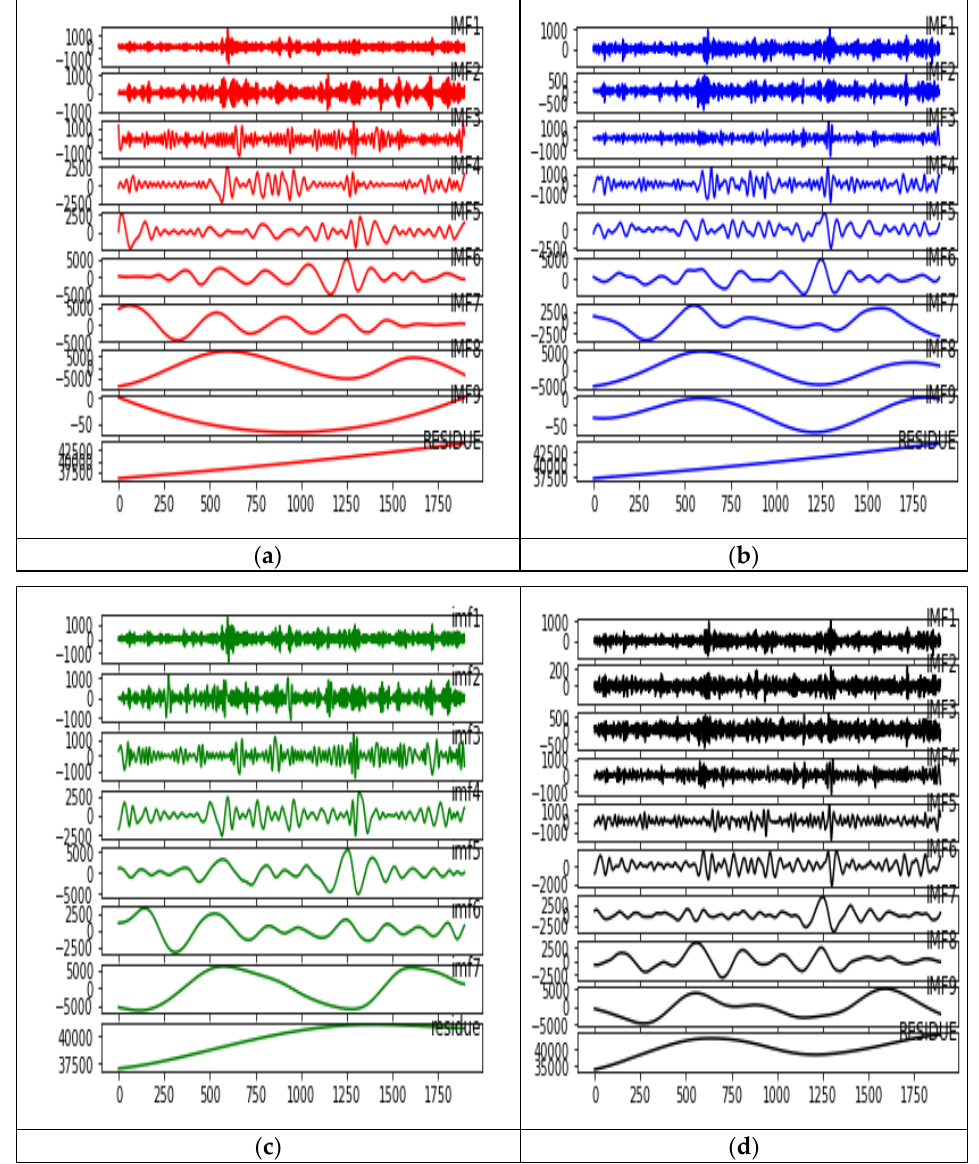
Figure 5. Decomposition results of KSE-100 index with ( a ) EMD, ( b ) EEMD, and ( c ) SEMD ( d ) Akima-EMD ( d )